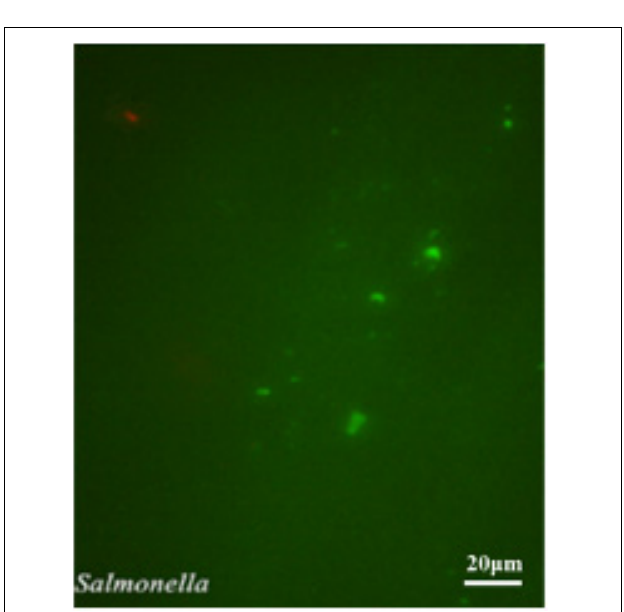
FIGURE 2 | The observation of unculturable Salmonella cells by fluorescence